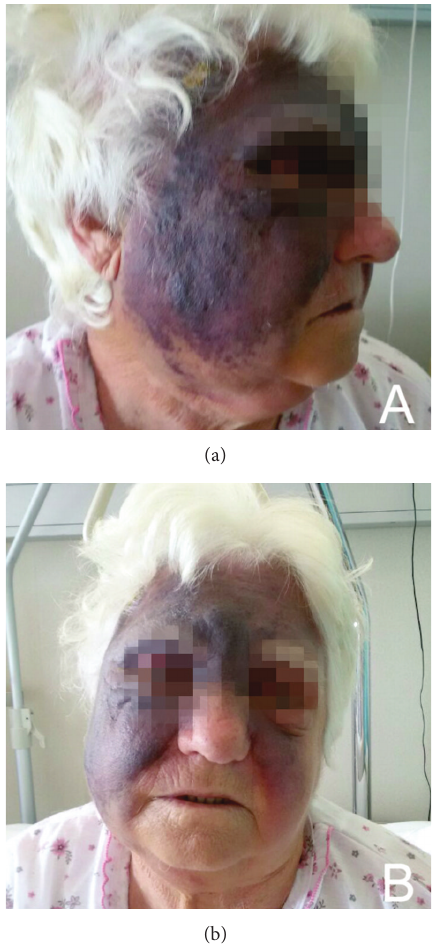
Figure 2: Chest CT scan at baseline (a) and after second course of chemotherapy administration, with the replacement of lung tissue by connective tissue